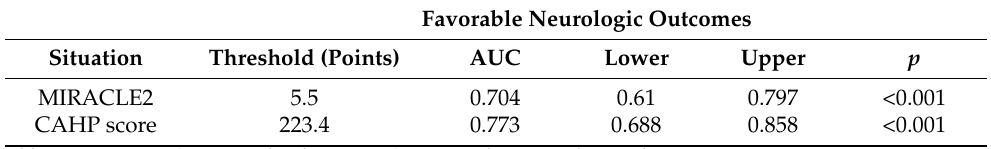
Table 4. Receiver operating characteristic (ROC) curve analysis of the optimal threshold for predicting favorable neurologic outcome.